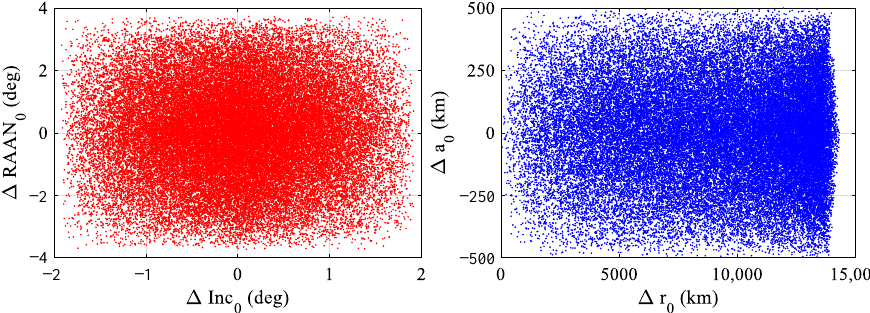
Figure 5. The disparity of the initial parking orbits of the pursuer and evader of all sample scenarios.